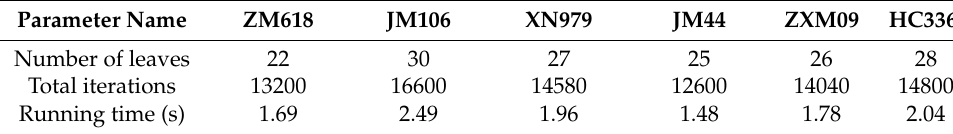
Table 6. Time consumption in modelling wheat plant leaf